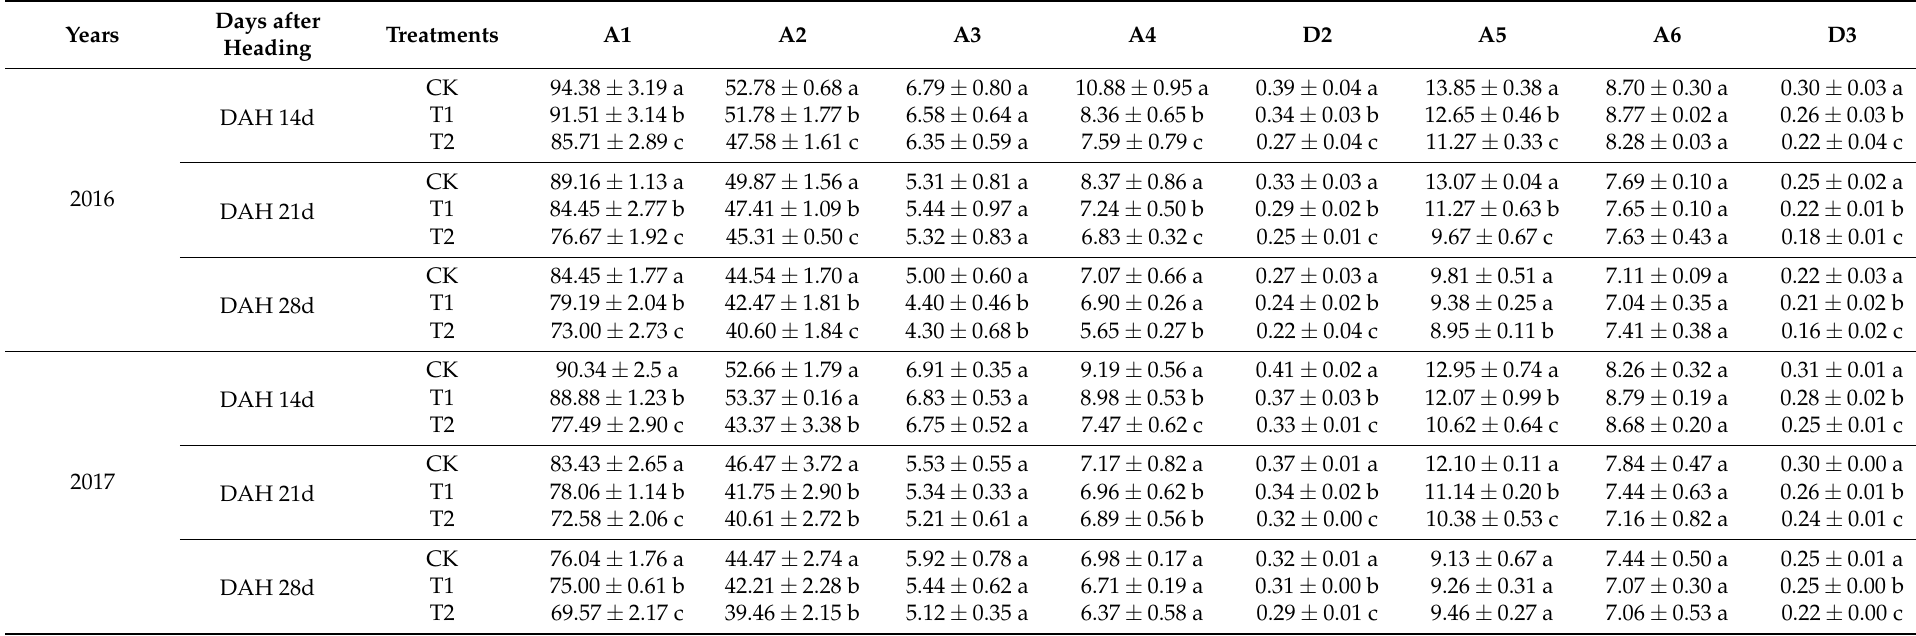
Table 6. Absorption feature parameters of rice canopy spectra curve under different